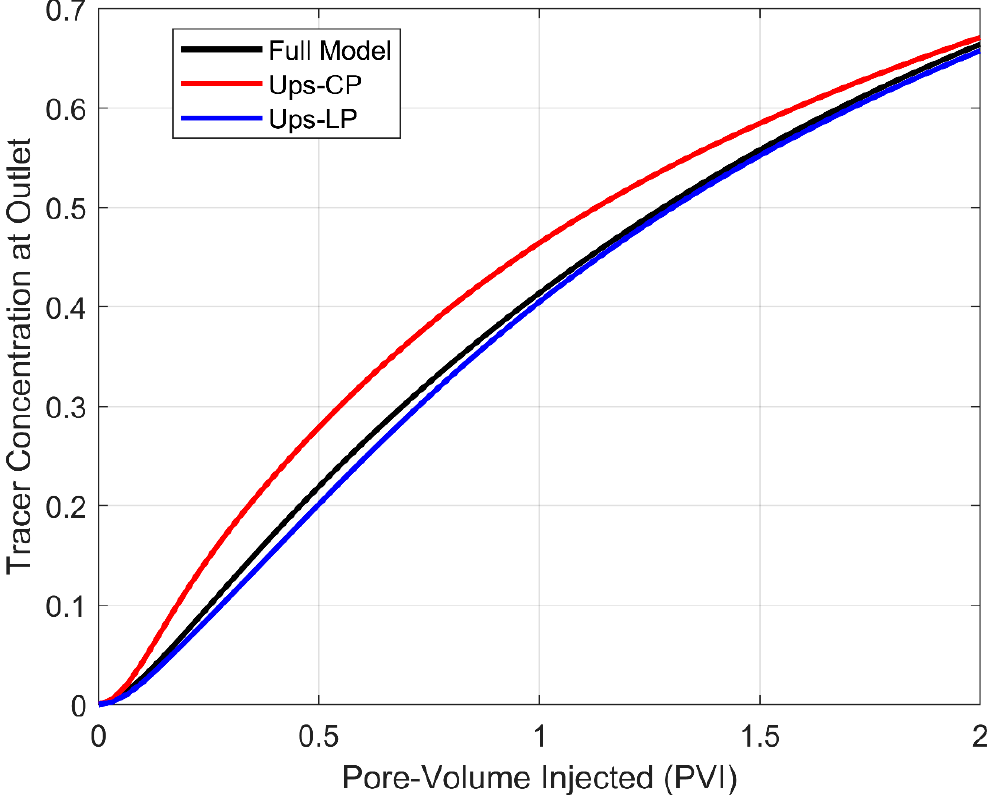
Figure 21. Case 3: tracer concentration at the outlet as a function of pore-volume injected.